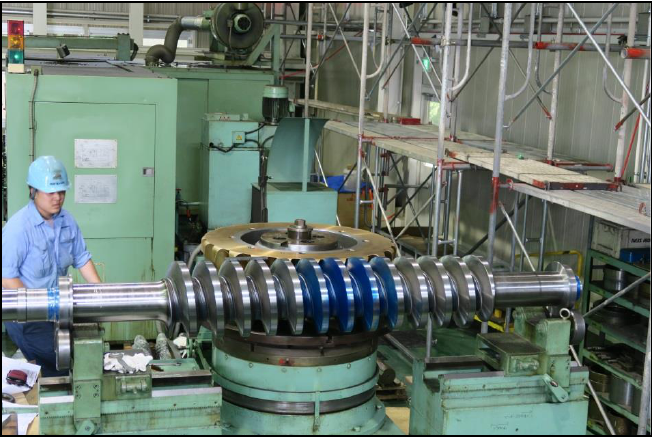
Figure 11. Worm gear set on gear testing apparatus.